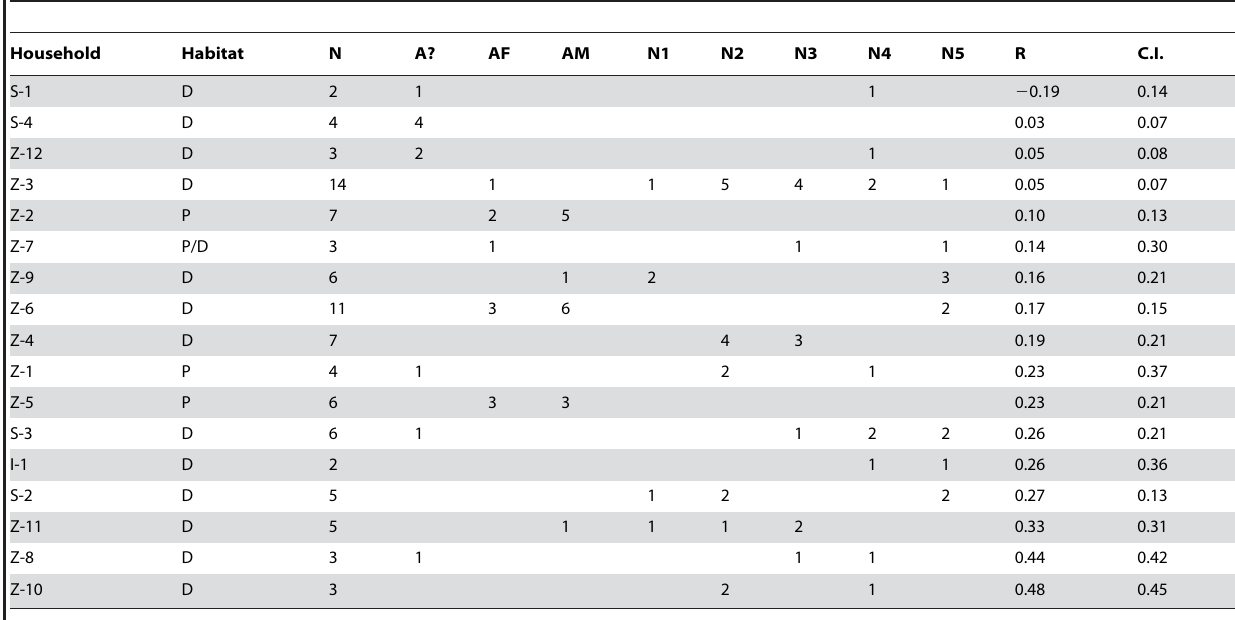
Table 7. Average relatedness and confidence intervals among T. infestans collected from households from 3 communities in Chuquisaca,